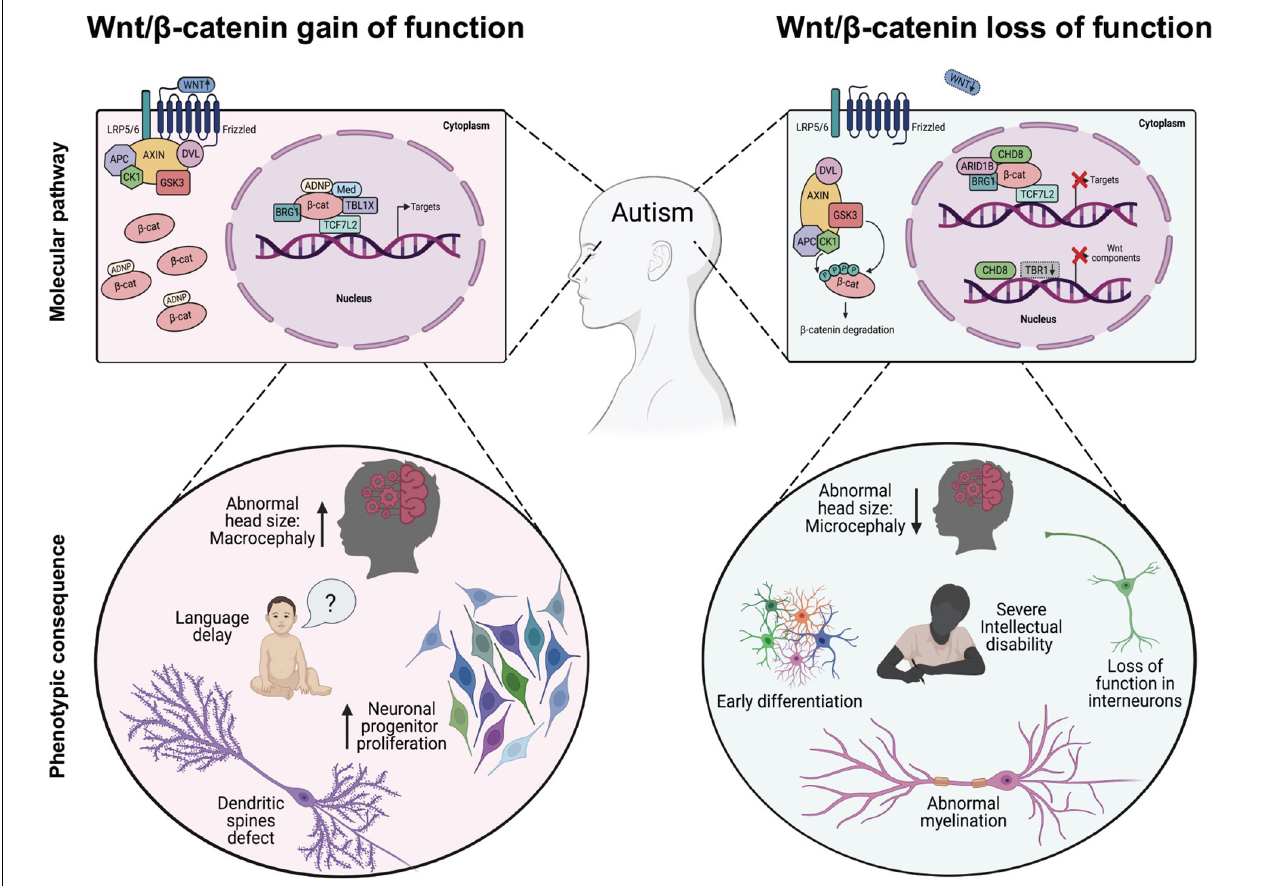
FIGURE 2 | Dysregulation of Wnt/ β -catenin-dependent transcription associated with phenotypic changes observed in autism spectrum disorders (ASD). In the Wnt/ β -catenin-gain of function models ( left panel ), expression of transcription factors or chromatin remodeling proteins enhance Wnt/ β -catenin signaling, either through direct binding with β -catenin that induces its cytosolic stabilization (i.e., ADNP) and/or its binding to target promoter region (i.e., MED12, TBL1X, BRG1, and TBL1XR1) leading to the appearance of some cellular and phenotypic traits observed in ASD. In the Wnt/ β -catenin-loss of function models (right panel), inhibitory proteins interfere with the normal transcriptional activity of β -catenin through downregulating the expression of target genes (i.e., CHD8) or reducing the expression of functional components of the cascade, such as Fzd1, Fzd2, Dvl2, Dvl3, Wnt7b, and CTNNB1 (i.e., CHD8 and/or TRB1 cKo) thus promoting the appearance of other well studied cellular and phenotypic traits observed in